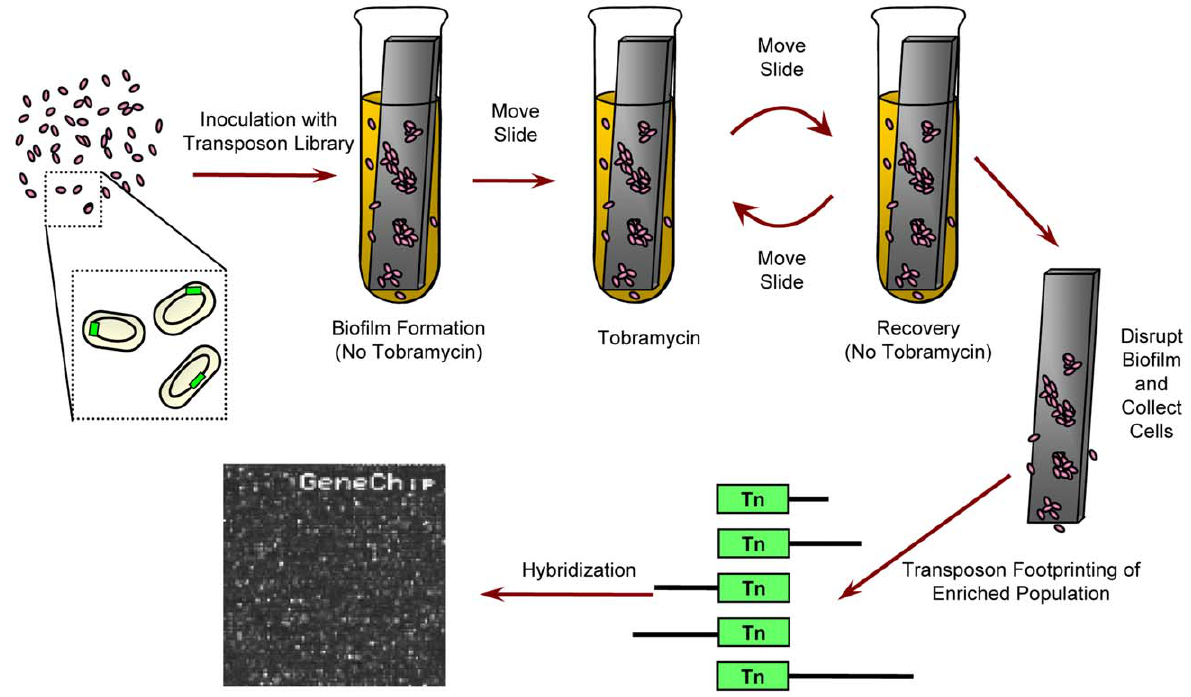
Figure 1. Experimental design. For biofilm experiments, a transposon insertion library was given 24 hours to form a biofilm on a plastic slide in media lacking tobramycin. Next, the slide and the attached biofilm were moved to fresh media with tobramycin for another 24 hours, and then the biofilm was allowed to recover in fresh, drug-free media for an additional 24 hours. After repeating the drug exposure and recovery a second time, the biofilm was disrupted and the cells were collected. Abundance of individual mutants was determined using microarray-based genetic footprinting. Planktonic experiments were similar except the slide was not included and cultures were shaken. Tobramycin was omitted from ‘‘no drug’’ controls. In all cases, containers were sealed. See Materials and Methods for